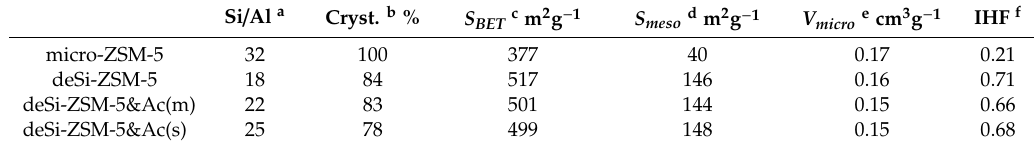
Figure 2. STEM images and EDX maps of Si and Al distribution in studied zeolites. Table 1. Chemical composition, crystallinity and textural parameters of studied zeolites.